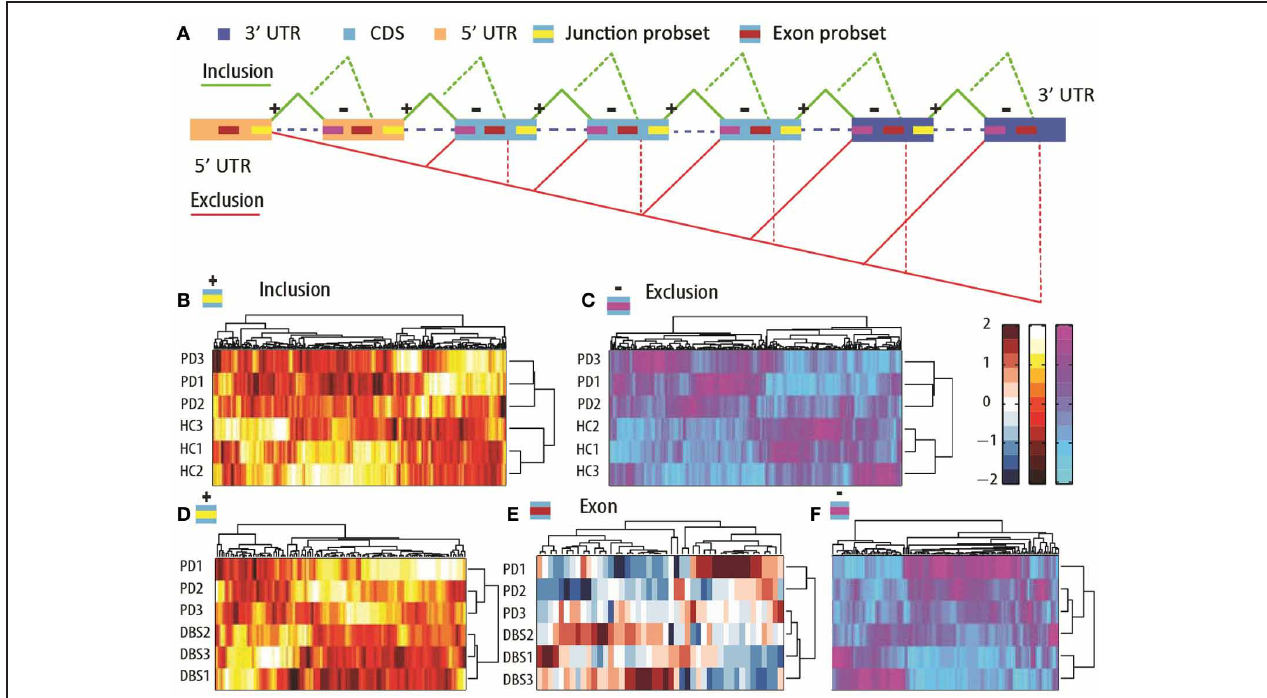
two tested states. (B) The global expression of inclusion junction array probe sets that were detected as changed classified patients from healthy volunteers successfully. (C) Classification by the exclusion junction probe-sets. (D) Classification following DBS classified post-DBS from pre-treatment state by inclusion detected probe-sets. (E) Internal exon classification of the post-DBS from pre-DBS states by PSRs. (F) Classification by the DBS-modified exclusion junction probe-sets. Distance method for all the clusterograms: city